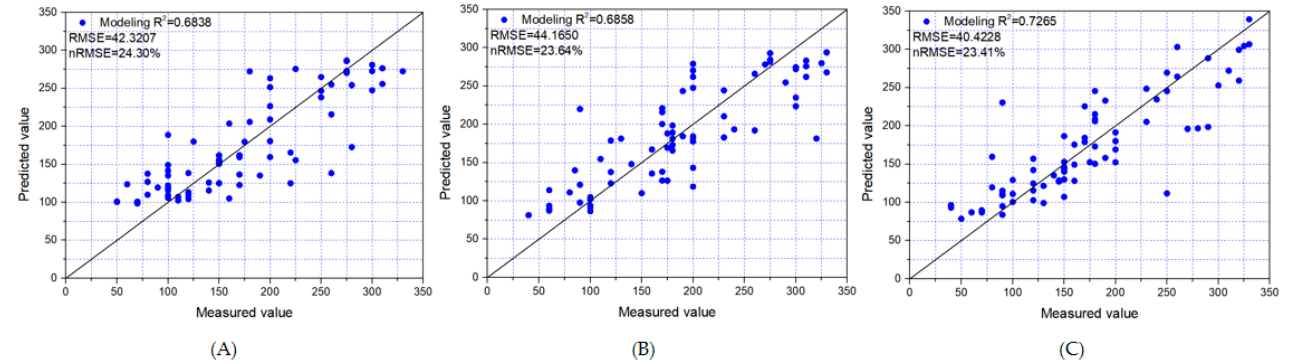
Figure 11. Multiple linear regression models of winter wheat tiller number with coverage, mean NDVI, and mean RVI for ( A ) variety 1, ( B ) variety 2, and ( C ) variety.